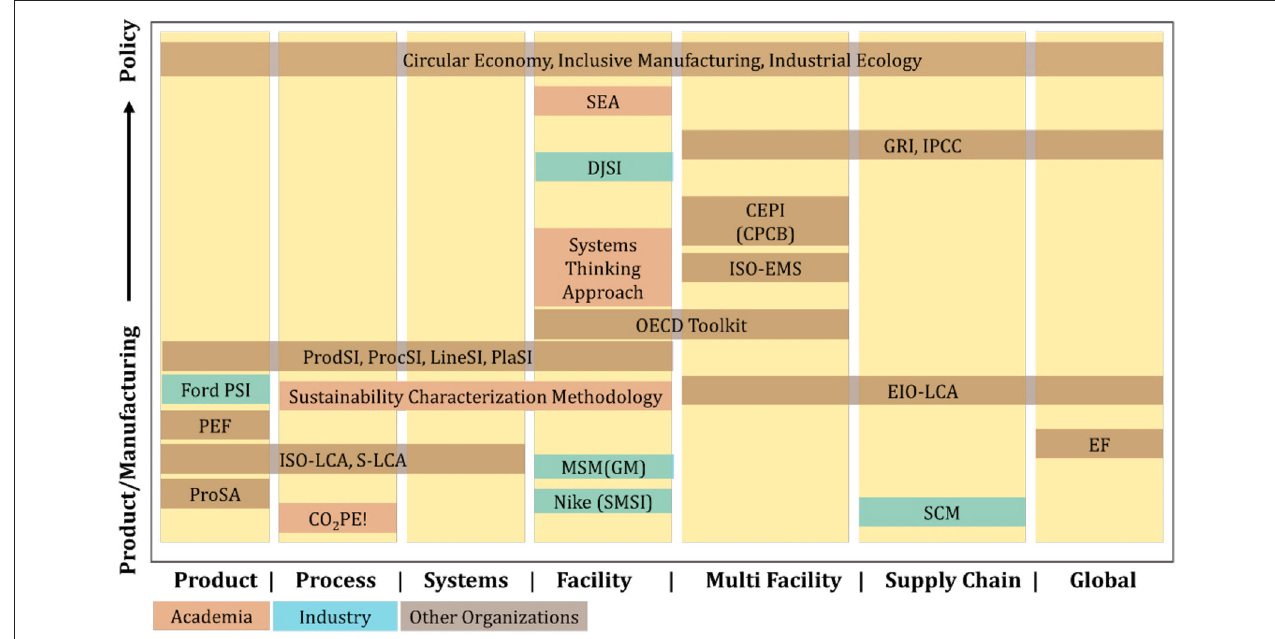
FIGURE 3 | SA measures in manufacturing at various levels, extended from Feng et al. (2010). CEPl (CPCB), Comprehensive Environmental Pollution Index (Central for Pollution Control Board, India); CO2PE!, Cooperative Effort on Process Emissions in Manufacturing; DJSI, Dow Jones Sustainability Index; EF, Ecological Footprint; EIO-LCA, Economic Input Output Life Cycle Assessment; GRI, Global Reporting Index; Ford PSI, Ford Product Sustainability Index; IPCC, International Panel on Climate Change; ISO · LCA, ISO-Life Cycle Assessment MSM (Genera l Motors): Metrics for Sustainable Manufacturing; OECD, Organisation for